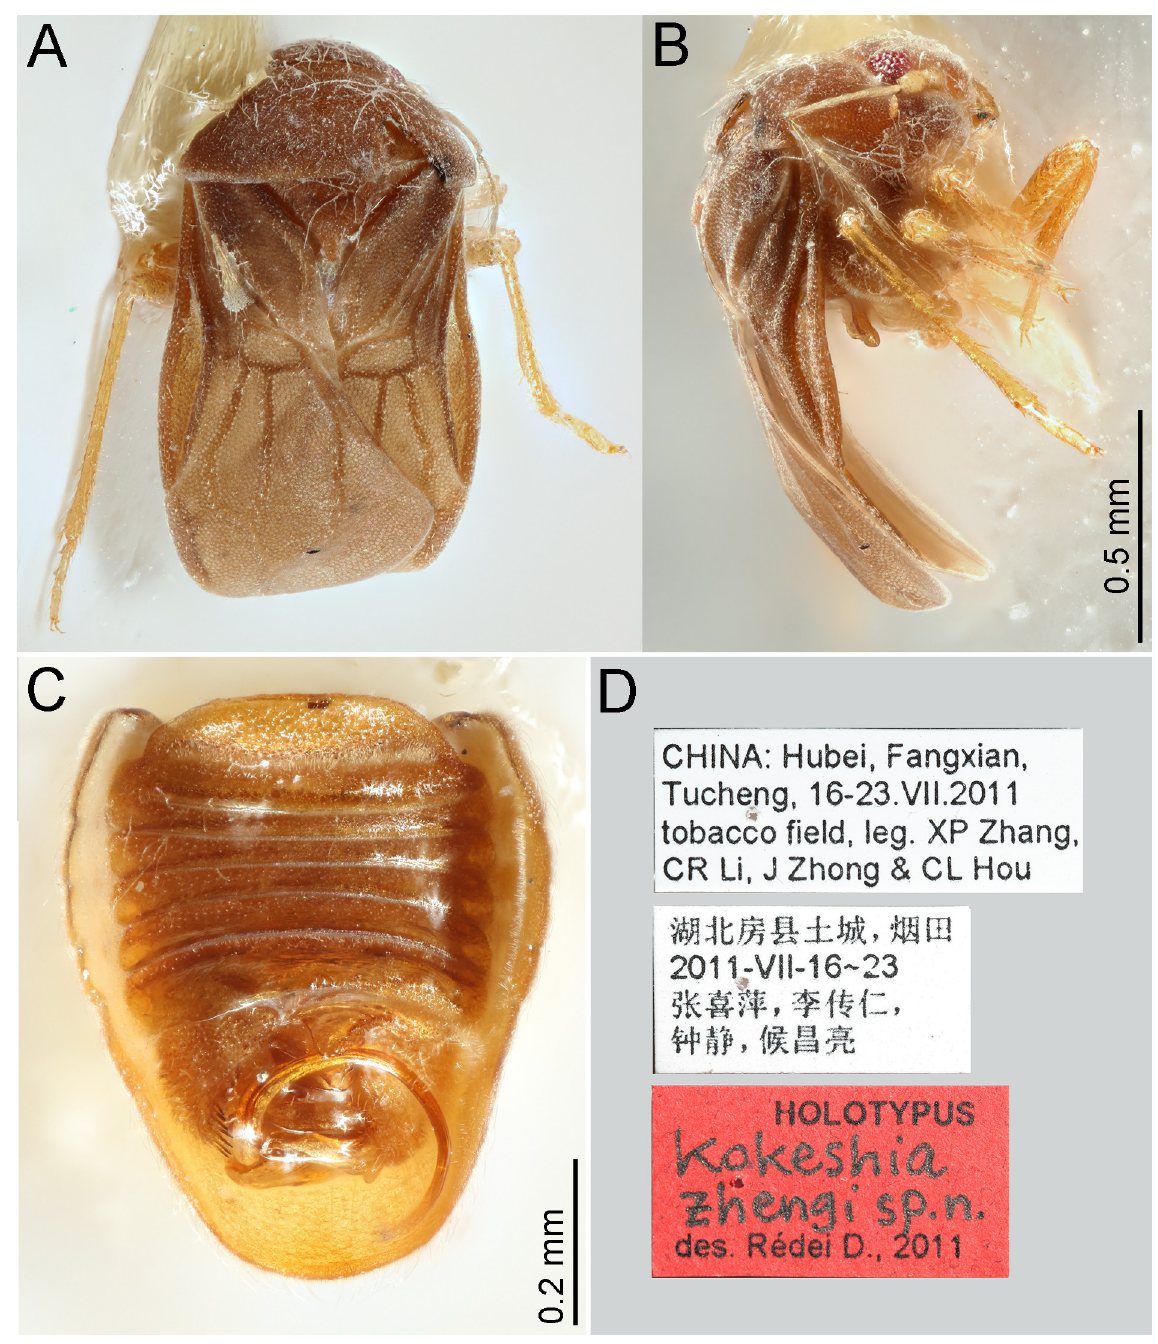
Fig. 25. Kokeshia zhengi Rédei, Ren & Bu, 2012. A‒D . Holotype, ♂ (NKUM). A . Dorsal view. B . Lateral view. C . Pregenital abdomen and genitalia, dorsal view. D .